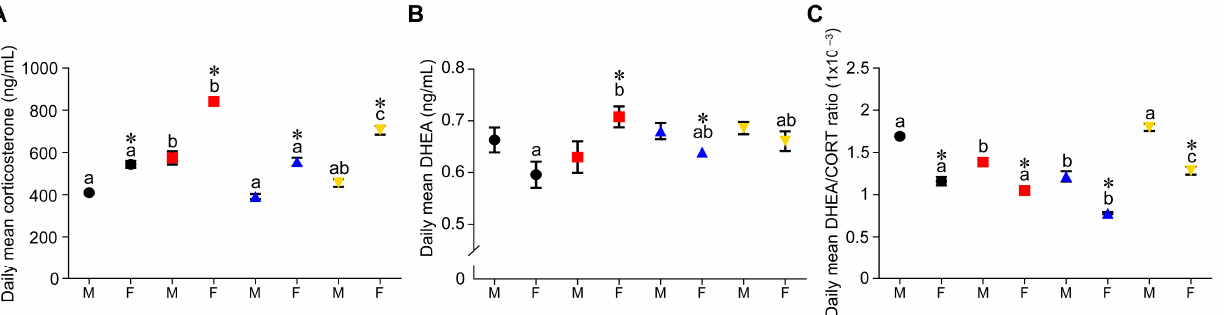
Figure 5. Mean daily values. ( A ) Serum corticosterone, ( B ) Serum DHEA and ( C ) Serum DHEA:CORT ratio in male (M) and female (F) in the four groups: CC (black circles), RR (red squares), CR (blue triangles) and RC (yellow inverted triangles). Data are mean ± SEM, group n = 6 per group at all ages except PND 850 where n = 5. p < 0.05 for data not sharing at least one letter within different groups of the same sex. * p < 0.05 male vs. female.